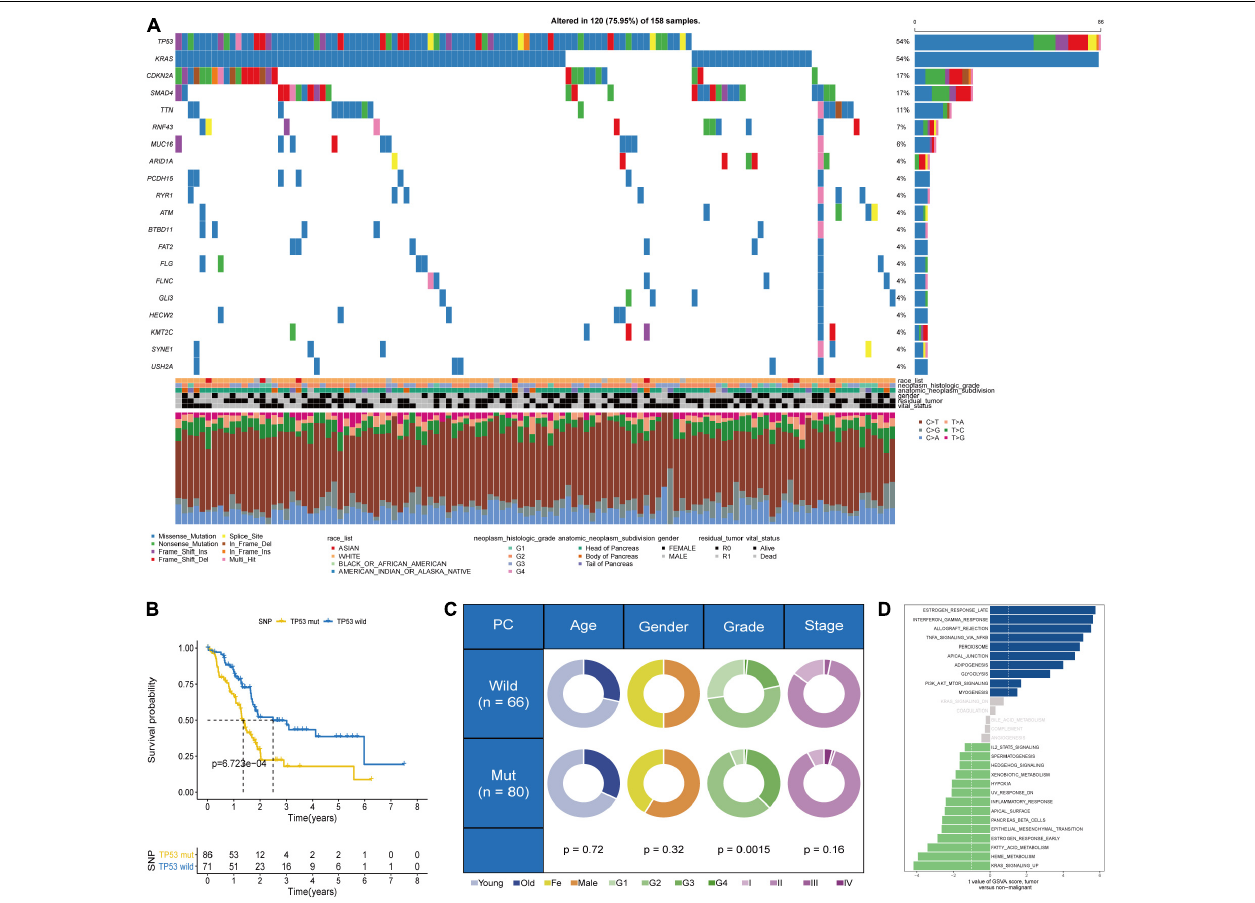
FIGURE 1 | Somatic mutational phenotypes based on the TP53 mutational status in The Cancer Genome Atlas (TCGA) dataset. (A) Genomic mutational landscape of pancreatic cancer (PC) in TCGA dataset. (B) Kaplan–Meier survival analysis showing that overall survival (OS) was significantly worse in PC patients with TP53 mutation than those without TP53 mutation. (C) Pie charts showing the chi-square test of clinicopathological factors in PC tumor samples. (D) Difference in the pathway activities scored by Gene Set Variation Analysis (GSVA) between PC patients with and without TP53